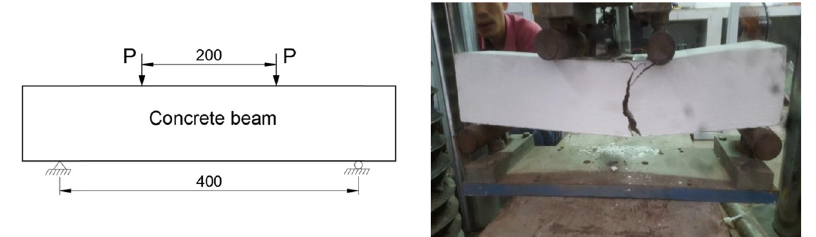
Figure 4: Four - point bending test.